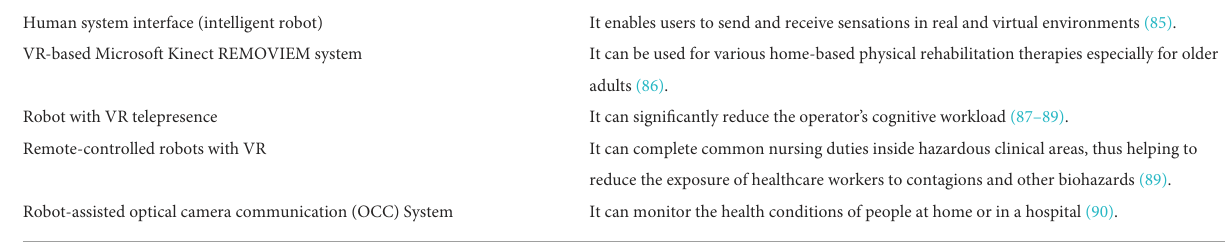
TABLE 2 Smart healthcare with 5G + VR/AR.